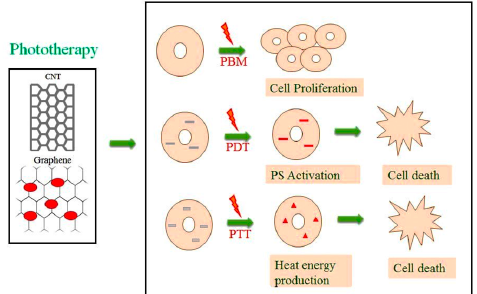
Figure 1. Mechanism action of phototherapy. CNT—carbon nanotubes, PS—photosensitizers, PBM—photobiomodulation mechanism of light source on cells leads to cell